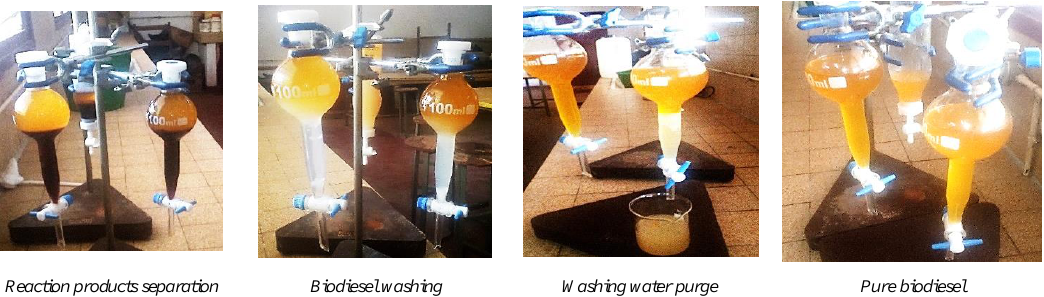
Figure 3. Illustration of biodiesel separation and purification operations.